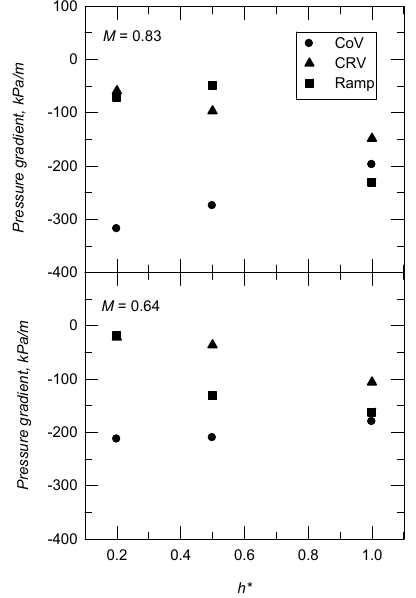
M = 0.83. For a conventional VG, counter-rotating vortices (CRV and Ramp VGs) induce a greater favorable pressure gradient and there is less difference between the results for different VG configurations.